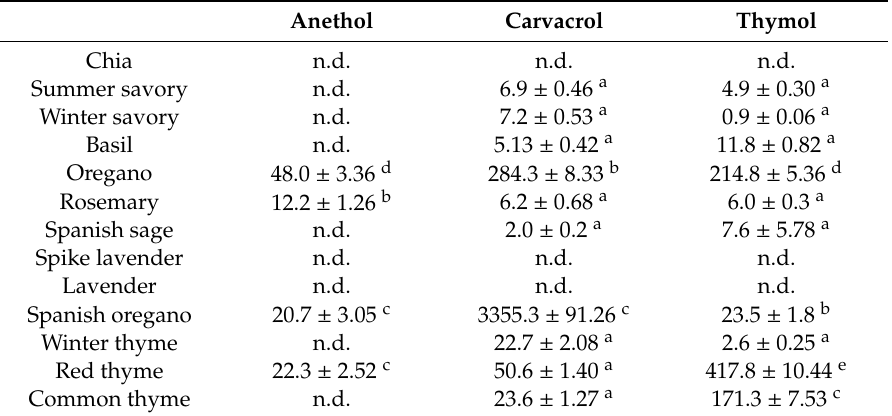
Table 3. Phenolic monoterpenes quantified in the seed oils (mg / 100 g of oil).